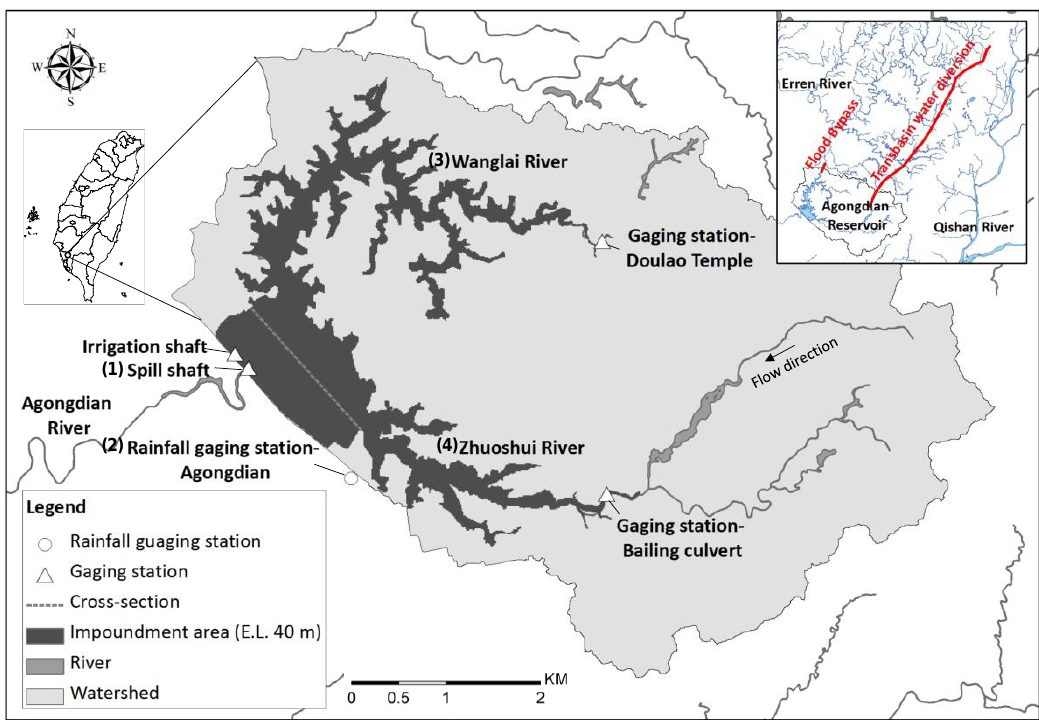
Figure 1. Aerial view of the Agongdian Reservoir watershed, southern Taiwan, includes: the (1) spill shaft within the reservoir; (2) rainfall gauging station; (3) Wanglai River (tributary) with a gauging station located at its headwaters near Doulao Temple; (4) Zhuoshui River (triburary) with a gauging station located at Bailing Culvert.